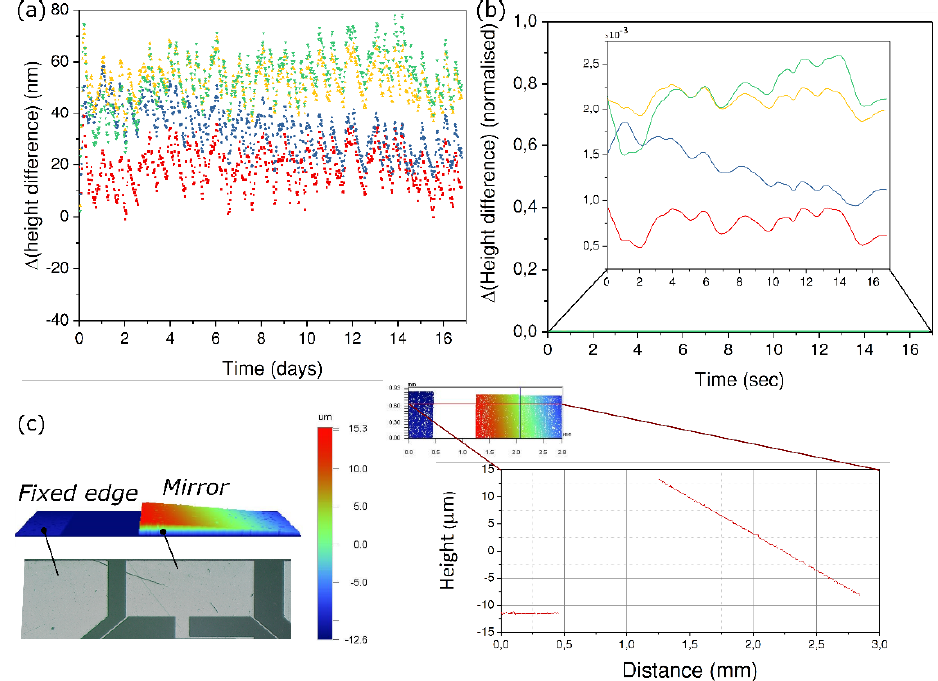
Figure 9. Stability analysis of the mirror in the deformed state. ( a ) The change in height difference between four arbitrary points on the mirror surface and a fixed point on the static edge. ( b ) The normalized variation. ( c ) A 3D color map of the deformed mirror (left) and a line plot of the height variation across the mirror (right). The height difference between the mirror and the base is used to normalize the data in ( b ).